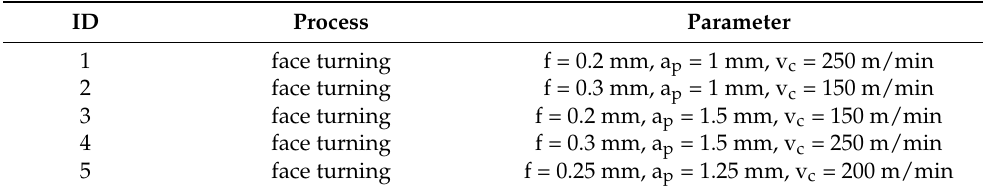
Table 1. Cutting